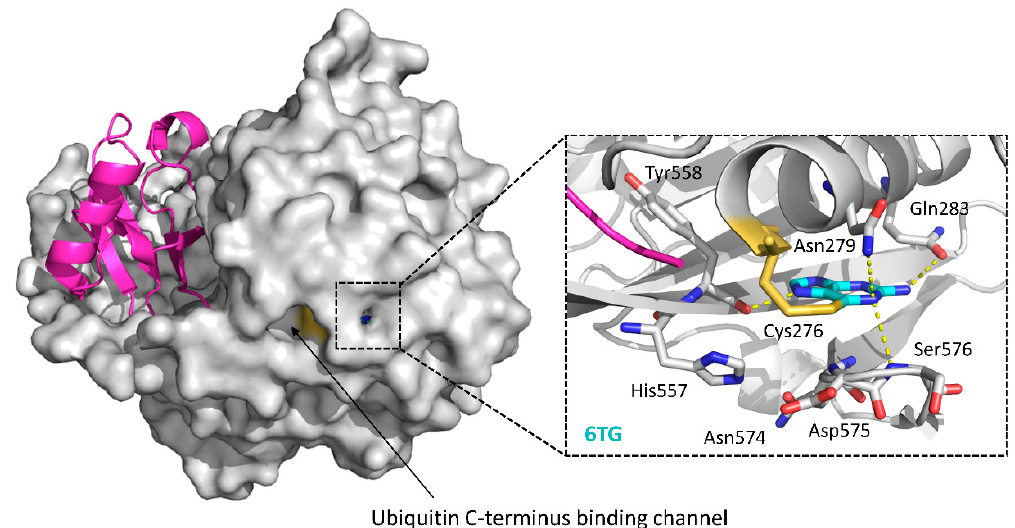
Figure 7. Cocrystal structure of the USP2-Ub-6TG complex and a close-up on the 6TG-binding site (PDB ID: 5XU8). Ubiq- uitin: magenta; USP2 catalytic domain: gray; 6TG: cyan sticks. In the close-up figure, hydrogen bonds made by 6TG are indicated by yellow dotted lines. Key residues involved in the interactions and the catalytic triad of USP2 (Cys276-His557- Asp574) are shown as sticks, with Cys276 in orange.